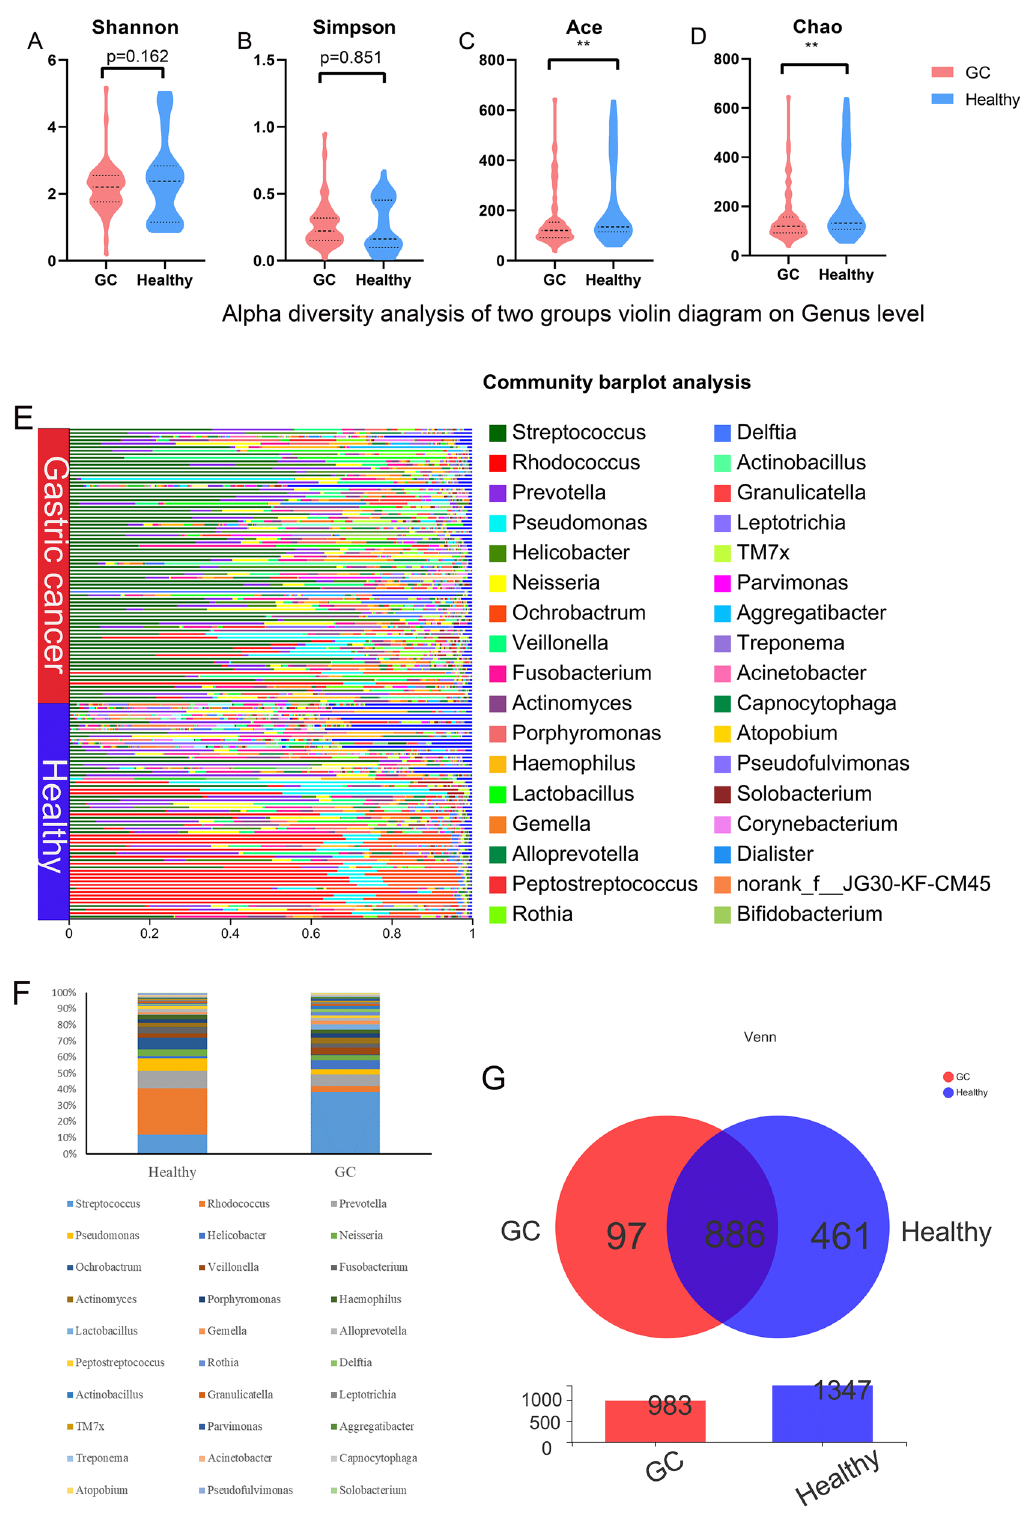
Fig. 1 Alpha diversity analysis and composition of bacteria in gastric juice samples from healthy individuals and GC patients. A Shannon index. B Simpson index. C Ace index. D Chao index. * represents a significant difference between the two groups (p < 0.05). E Community composition of the bacterial community. The ordinate is the name of the sample, and the abscissa is the proportion of bacteria in the sample. Different colors of the column represent different species, and the length of the column represents the size of the proportion of the species. F A histogram of percentage accumulation drawn for the top 30 bacteria with the highest abundance in the two groups. G Venn diagram. Red is GC, blue is healthy, and the num- ber of nonoverlapping species represents the number of species unique to the corresponding